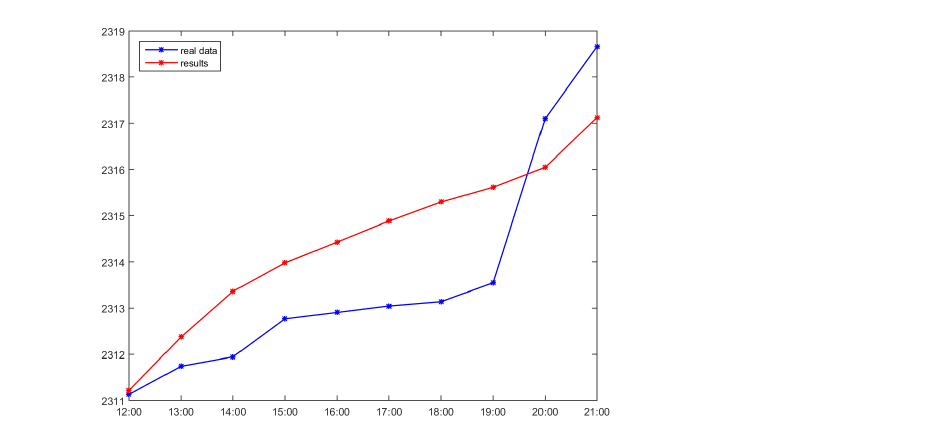
Figure 11. Comparison between the real data and results of the LSTM estimation-based compensa- tion method.